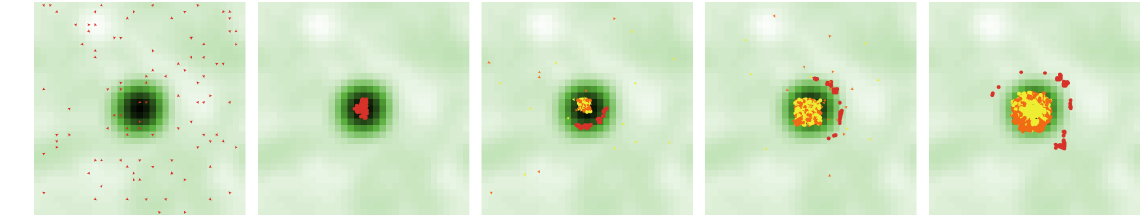
Figure 3. Evolution of Set B over time, from initialization (left) through end of simulation